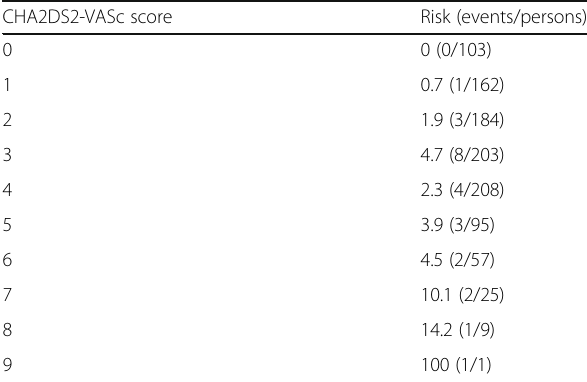
Table 2 The annual risks of thromboembolism (ischemic stroke, peripheral embolism, or pulmonary embolism) for CHA2DS2- VASc, adjusted for aspirin use [12]